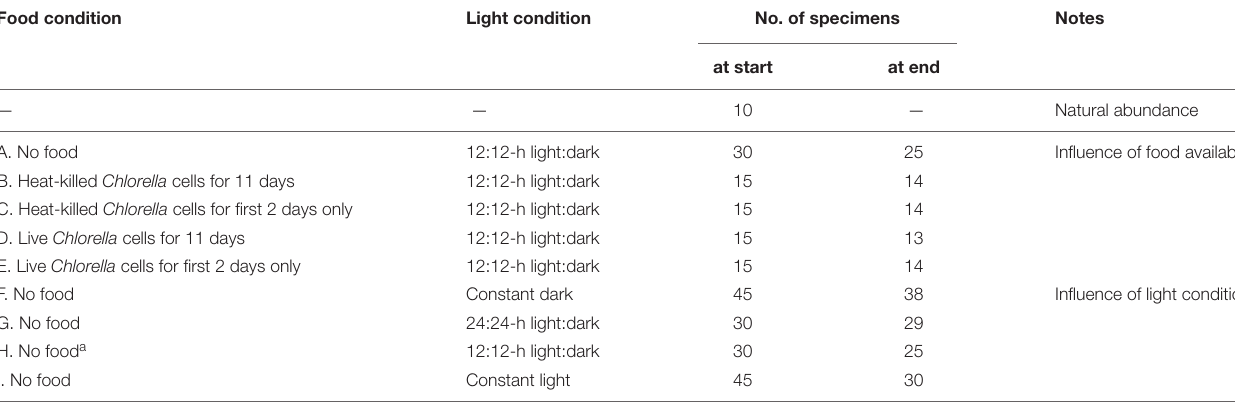
TABLE 1 | Food source and availability and light conditions in culture experiments. Food